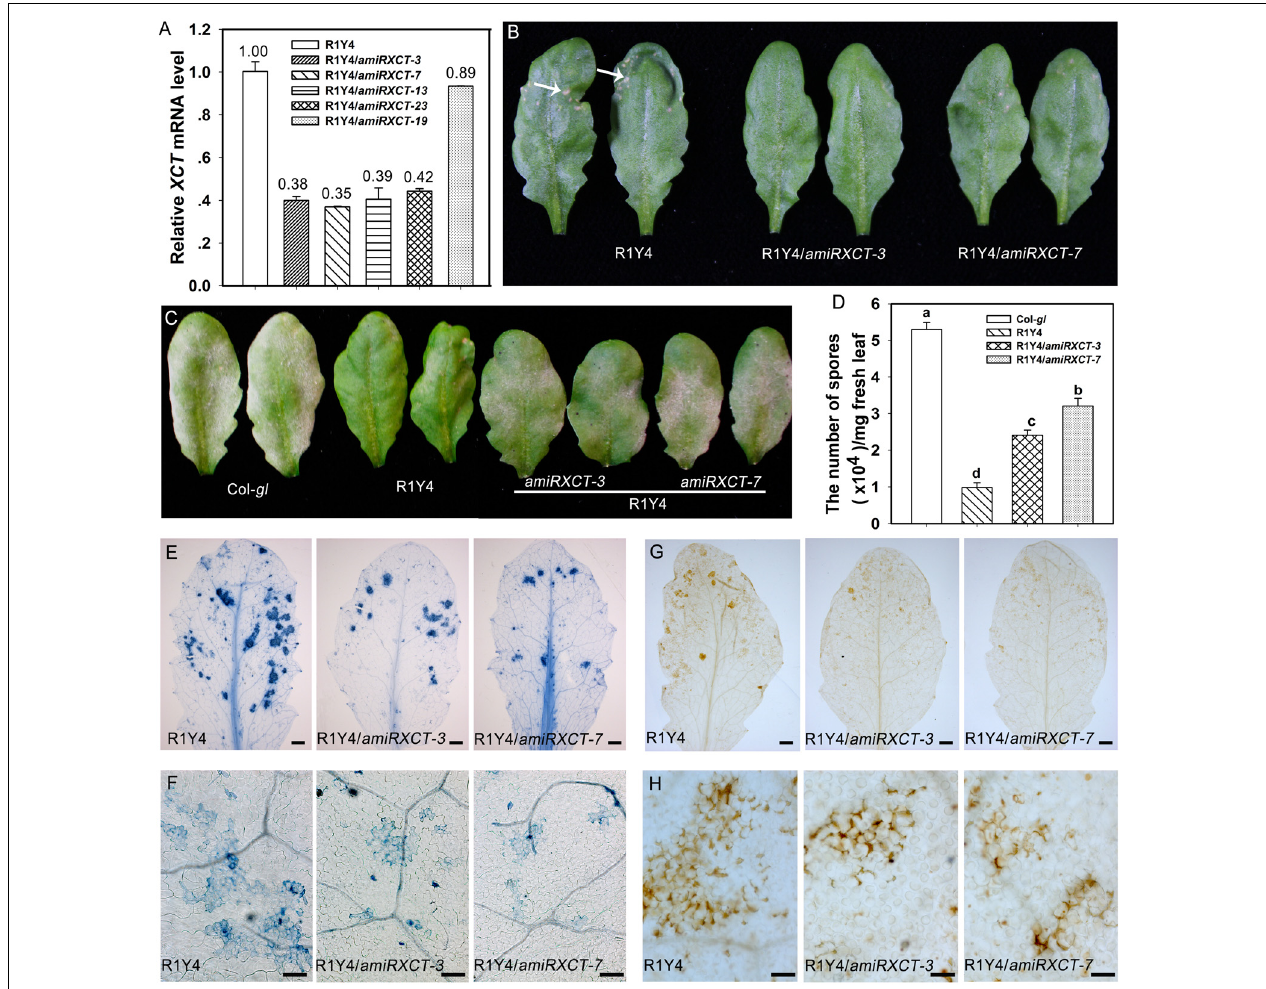
FIGURE 4 | Knocking-down XCT compromises RPW8.1 –mediated powdery mildew resistance. (A) Relative mRNA levels of XCT detected by quantitative RT-PCR (qRT-PCR) in the indicated transgene lines. The values above the column represent the relative level of XCT by arbitrarily setting the level of XCT in R1Y4 as 1. Error bars indicate SD ( n = 3). (B) The phenotype of representative leaves from 6-week-old plants in R1Y4 compared to that in the XCT knocked-down lines. Note the cell death lesions in R1Y4 (arrows) but there are less or no such cell death lesions in the knocked-down lines. (C) Representative leaves show the disease phenotypes of powdery mildew at 10 dpi. (D) Quantitative analysis of sporulation at 10 dpi on indicated lines in (C) . Error bars represent SD ( n = 6). Letters above the bars represent statistically significant differences ( P < 0.01). (E–H) Representative leaves (E,G) and leaf sections (F,H) stained by trypan blue (E,F) and DAB (G,H) from R1Y4 and XCT knocked-down lines at 10 dpi show clusters of cell death and H 2 O 2 accumulation, respectively. Scale bars: (E,G) 2 mm; (F,H) 50 µ